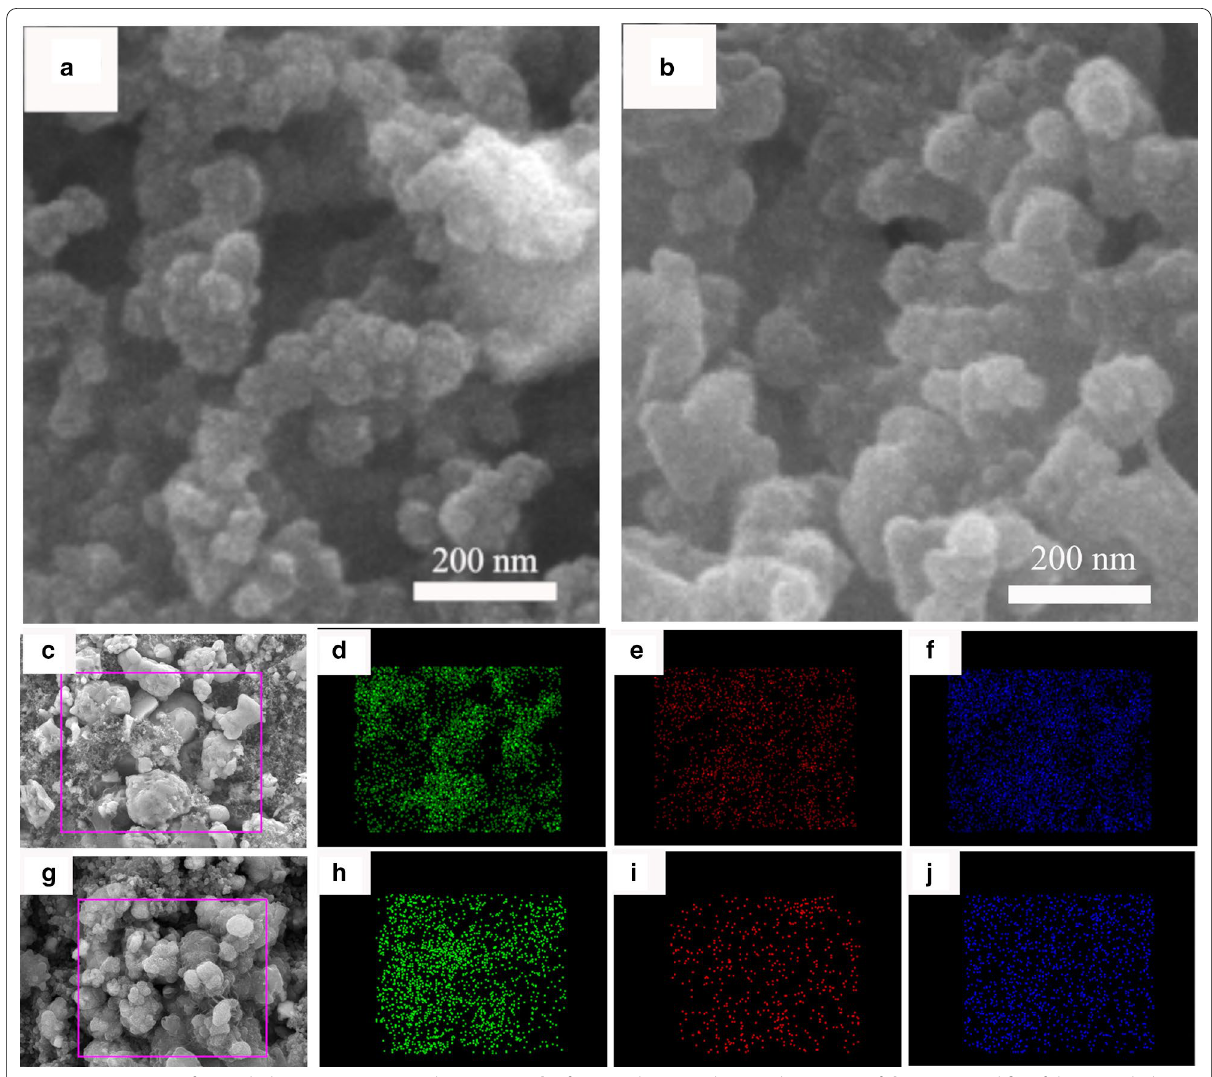
Fig. 8 SEM images of annealed Cu 2 SnS 3 nanoparticles: a at OCV, b after 5 cycles. EDX elemental mapping of d Cu, e Sn and f S of the annealed CTS electrode at OCV, h Cu, i Sn and j S of the annealed CTS electrode after 5